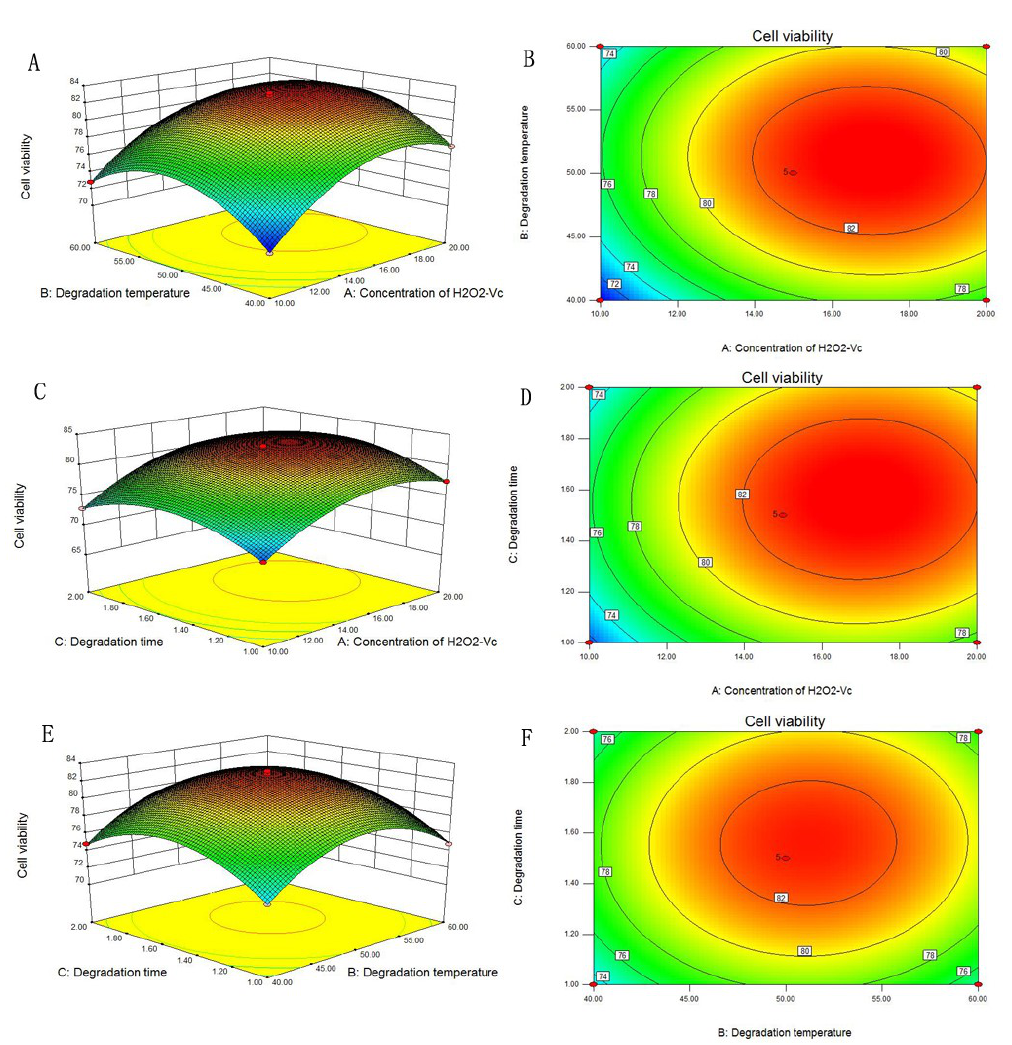
Figure 2. Response surface plots ( A , C , E ) and contour plots ( B , D , F ) of PC12 cells viability: the interaction between concentration of H 2 O 2 -Vc and degradation temperature ( A,B ), the interaction between concentration of H 2 O 2 -Vc and degradation time ( C,D ), and the interaction between degradation temperature and time ( E,F ).